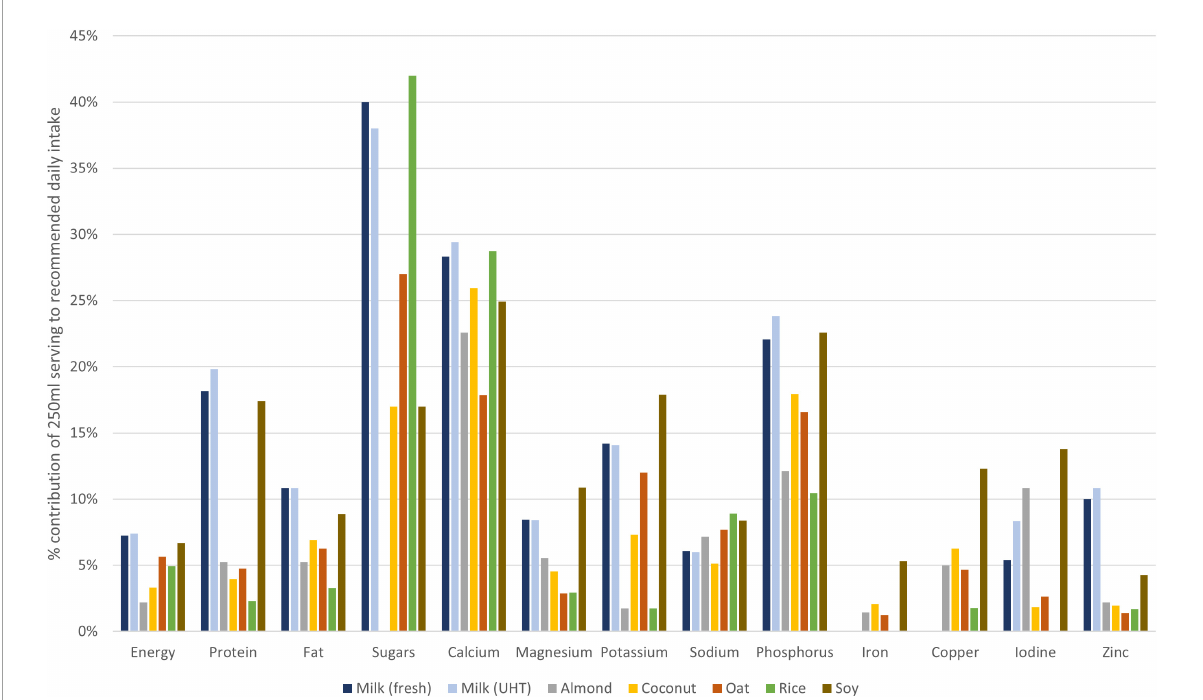
FIGURE2 Contribution of a single 250 mL serving of each product type to an adult woman’s recommended daily intake for selected nutrients. Bars show the mean nutrient content across the analyzed samples for each product